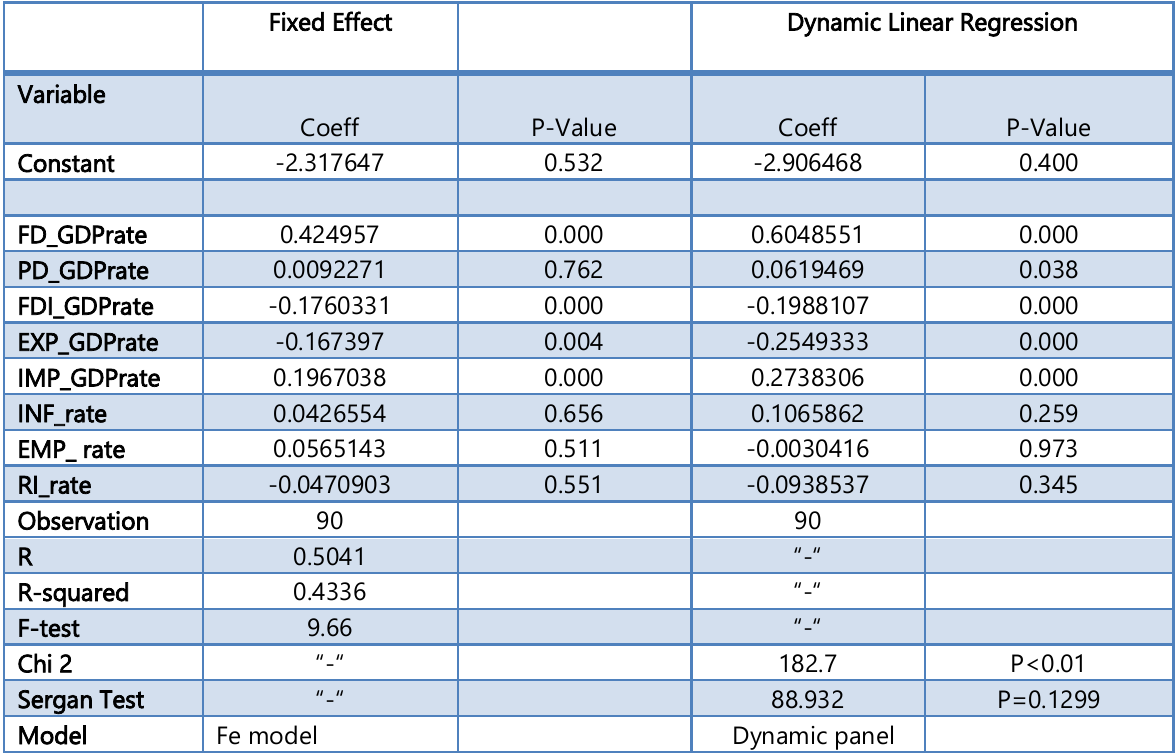
Table 4: Regression Results (Source: Authors‟